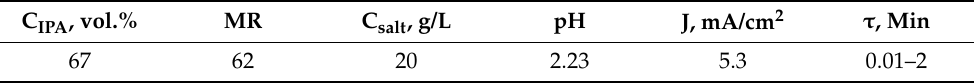
Table 6. The parameters of the reaction medium for determining the deposition time effect. C IPA ,